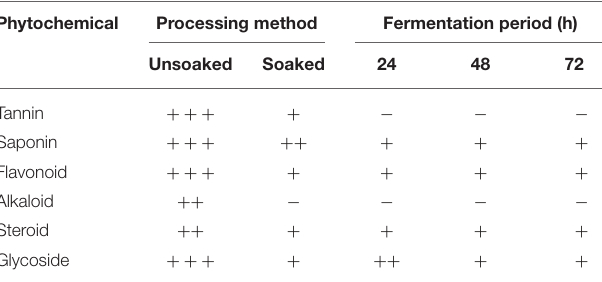
TABLE 6 | Preliminary assay for anti-nutritional factors and phytochemicals in African oil bean seed (Okorie and Olasupo, 2014).